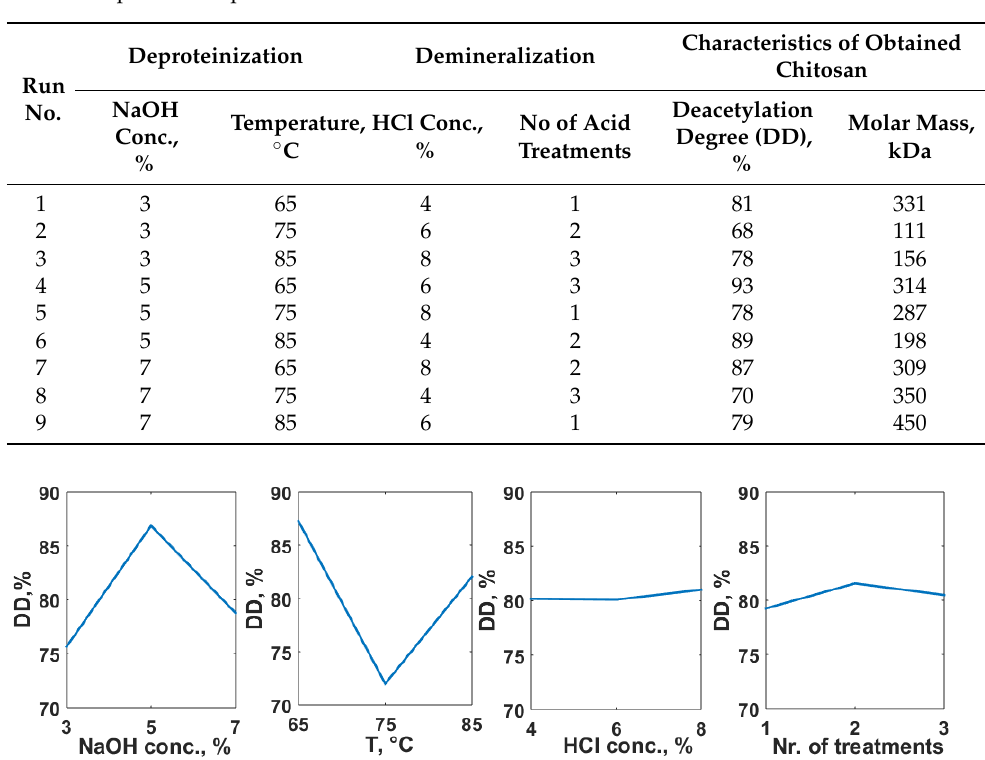
Table 2. Experimental plan and obtained chitosan characteristics.